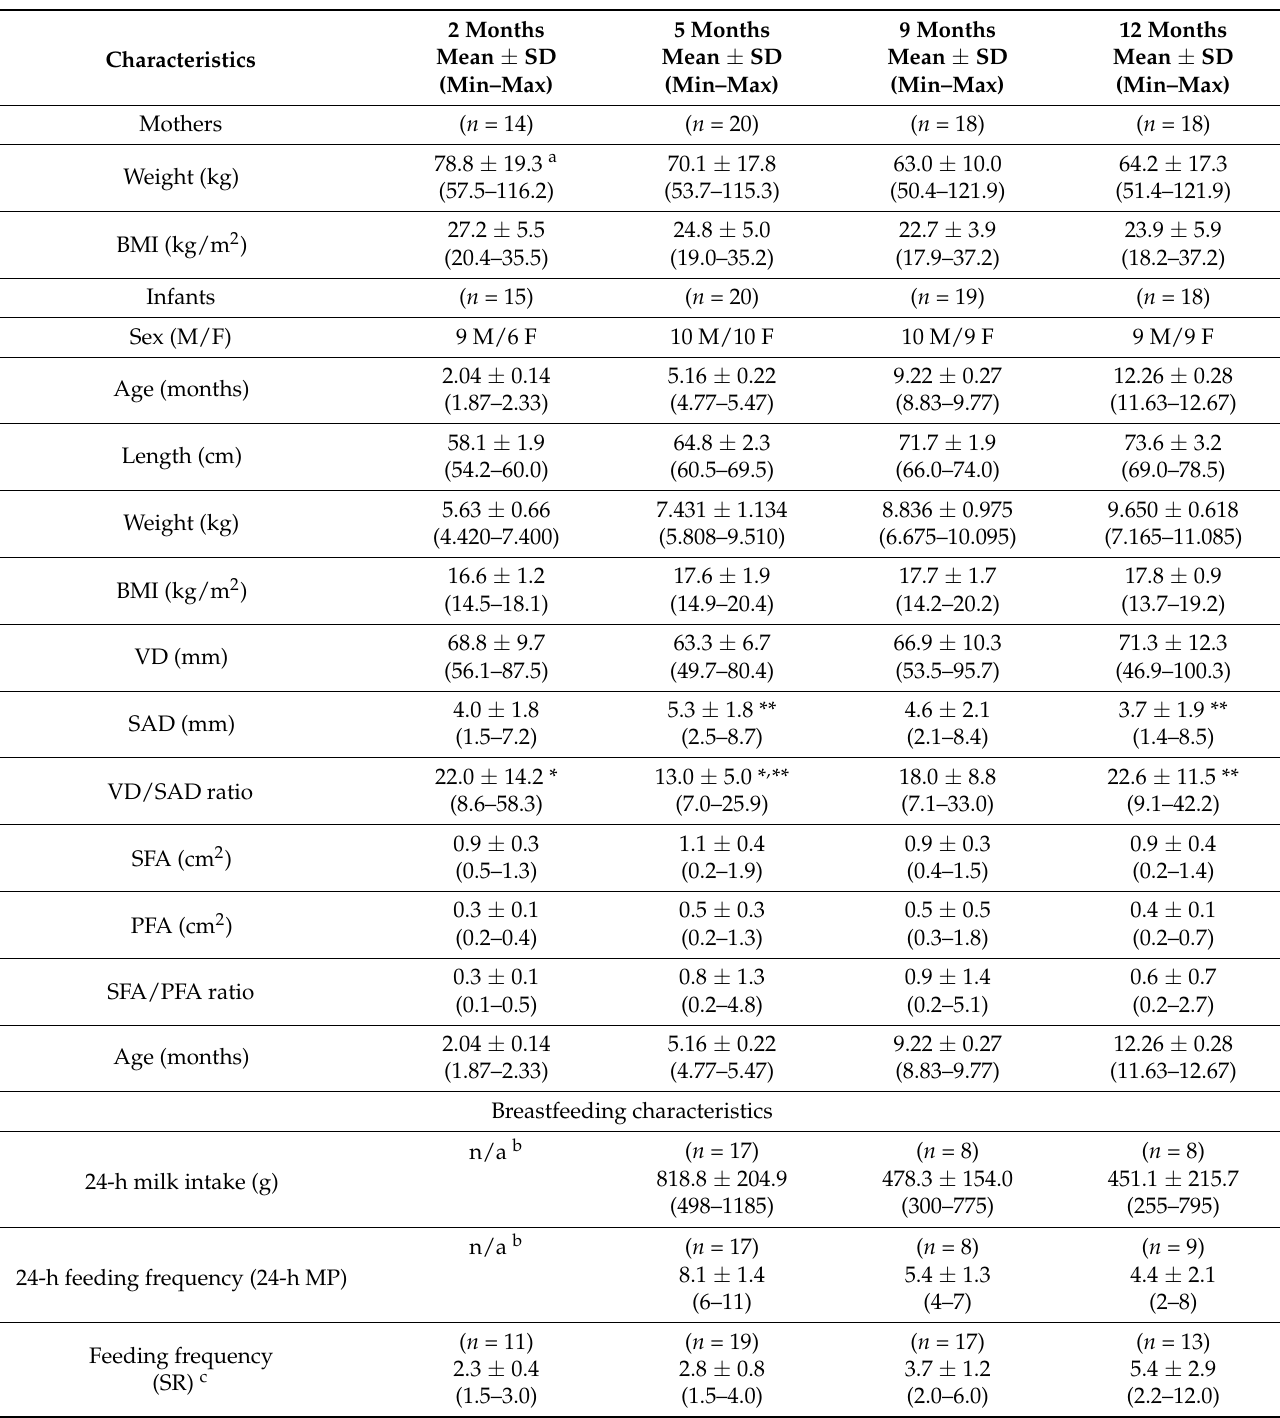
Table 1. Participant anthropometric, abdominal adiposity and breastfeeding